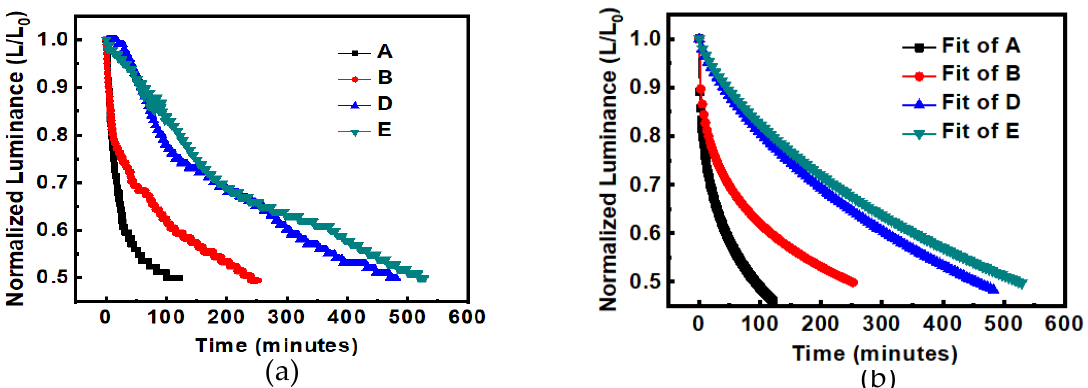
Figure 7. Comparisons of device lifetime ( a ) experimental data, ( b ) fit curves with the formula.